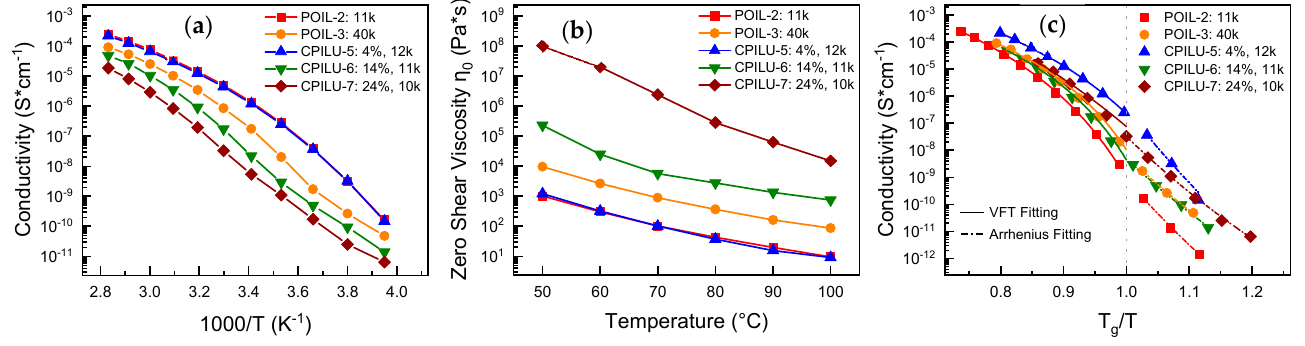
Figure 3. Conductivity σ of homo-/copolymer POIL-x and CPILU-y ( a ) as a function of inverse temperature 1000/T; ( c ) glass transition temperature divided by measurement temperature T g / T ; and ( b ) zero shear viscosity η 0 of homo-/copolymer POIL-x and CPILU-y versus temperature T .